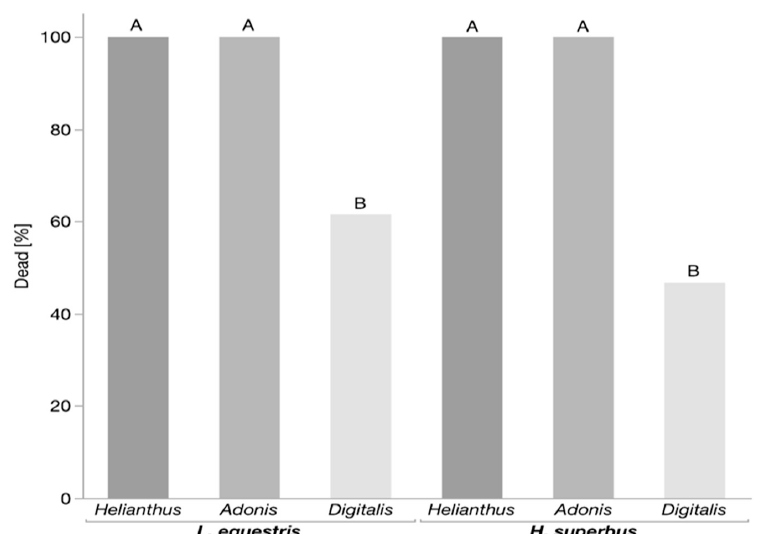
Figure 1. Survival of the milkweed bug larvae preyed upon by C. carnea . Bars represent the proportion of dead larvae after C. carnea attacks. The milkweed bugs L. equestris (n = 22–26 per treatment) and H. superbus (n = 15–16 per treatment), were raised on the seeds of either Helianthus annus (sunflower), Adonis vernalis , or Digitalis purpurea . Within the same insect species, levels not connected by the same letter are significantly different.